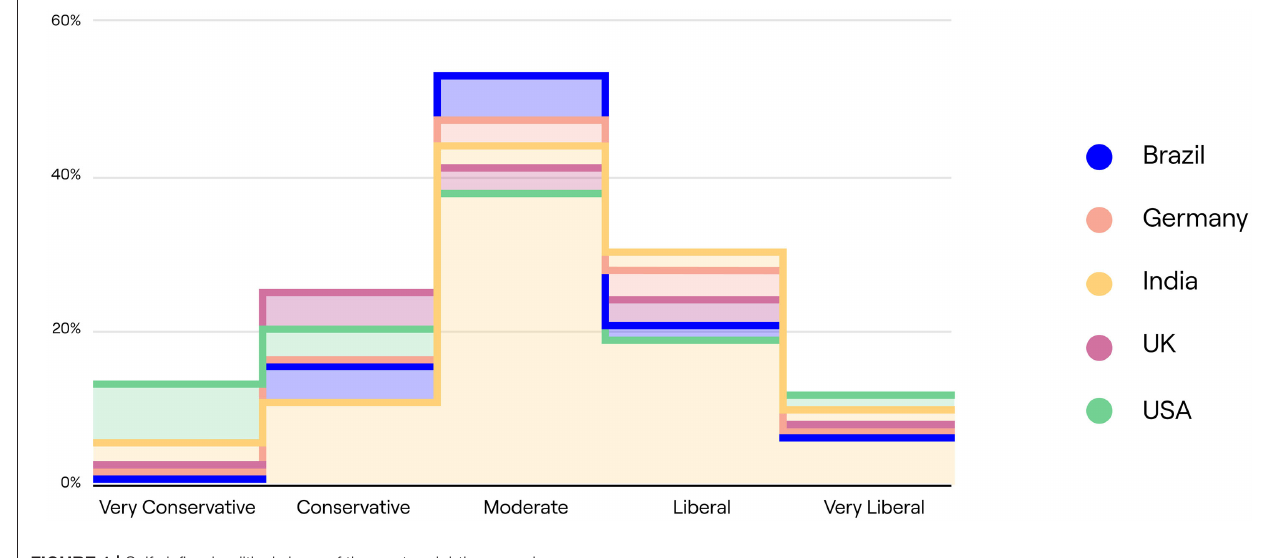
FIGURE 1 | Self-defined political views of the post-weighting sample.